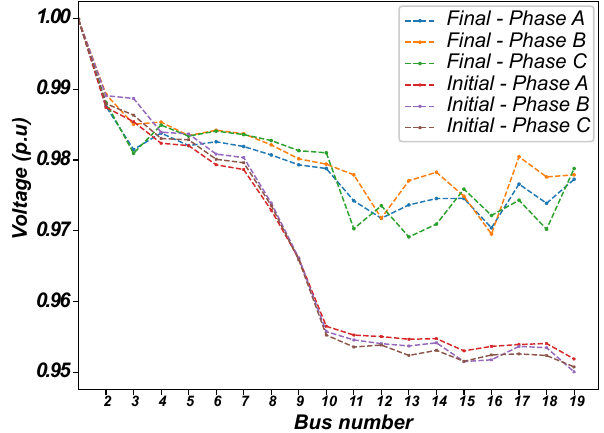
Figure 9. 19-bus and 20-branch system voltage levels (fixed).